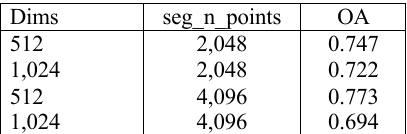
Table 4 . The varying number of dimensions for output codeword learned from AE. 512 and 1,024 in column “Dims” denotes 512-dimensional codeword and 1,024-dimensional codeword, respectively. “seg_n_points” denotes the input point size in the segmentation network training stage. Input point size in the AE training stage is